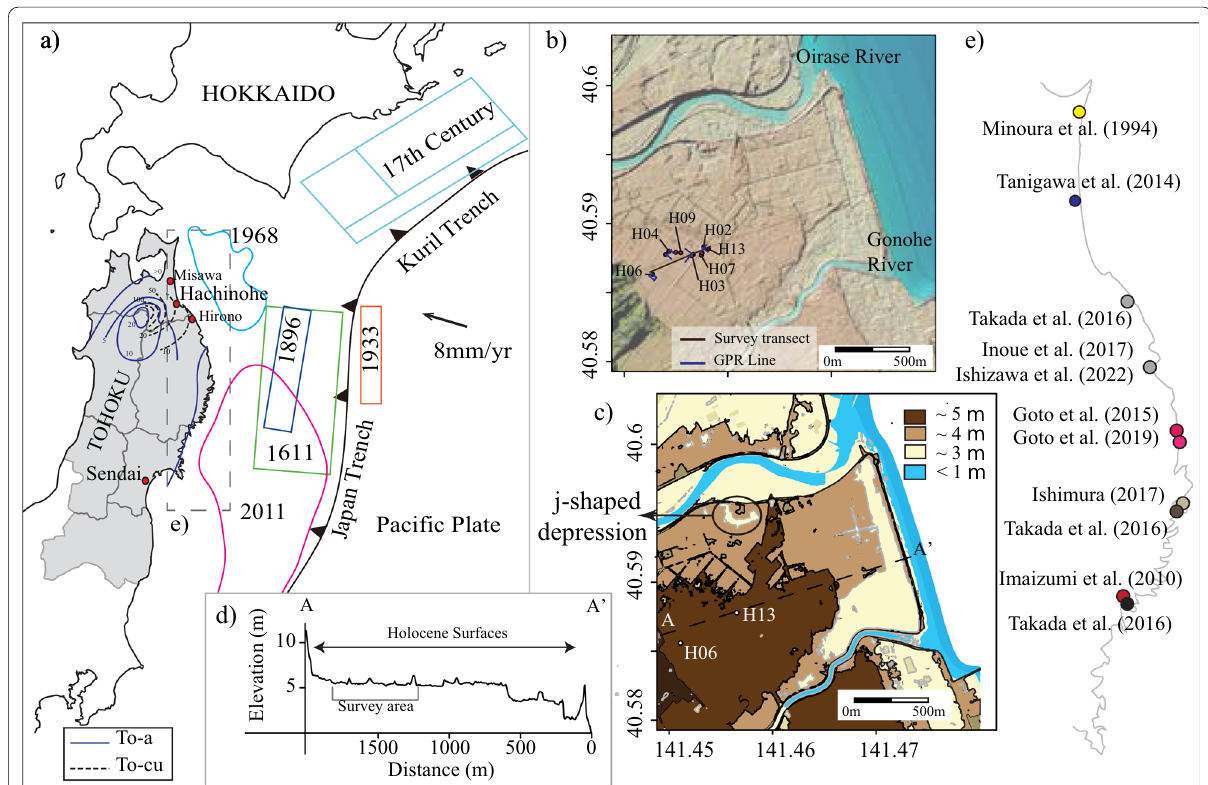
Fig. 1 Map of the study area. a Location of the modeled rupture areas for the tsunamigenic earthquakes of the seventeenth century, 1611, 1896, 1933, 1968, and 2011. (Hatori 1975; Tanioka and Satake 1996; Nagai et al. 2001; Ozawa et al. 2011; Ioki and Tanioka 2016; Uchida et al. 2016); To‑a and To‑Cu correspond to the isopachs of the respective tephra layers (Machida and Arai 2003). b Digital elevation model of the study area – 5 m grid size provided by the Geospatial Information Authority of Japan. c Topographic map of the study area. Colored areas evidenced the levels of uplifted marine terraces. d Cross‑section of the elevation model along the study area, from the A to A’. e Paleotsunami studies developed along the Sanriku Coast and the Shimokita Peninsula. The circles represent the approximate survey location for each